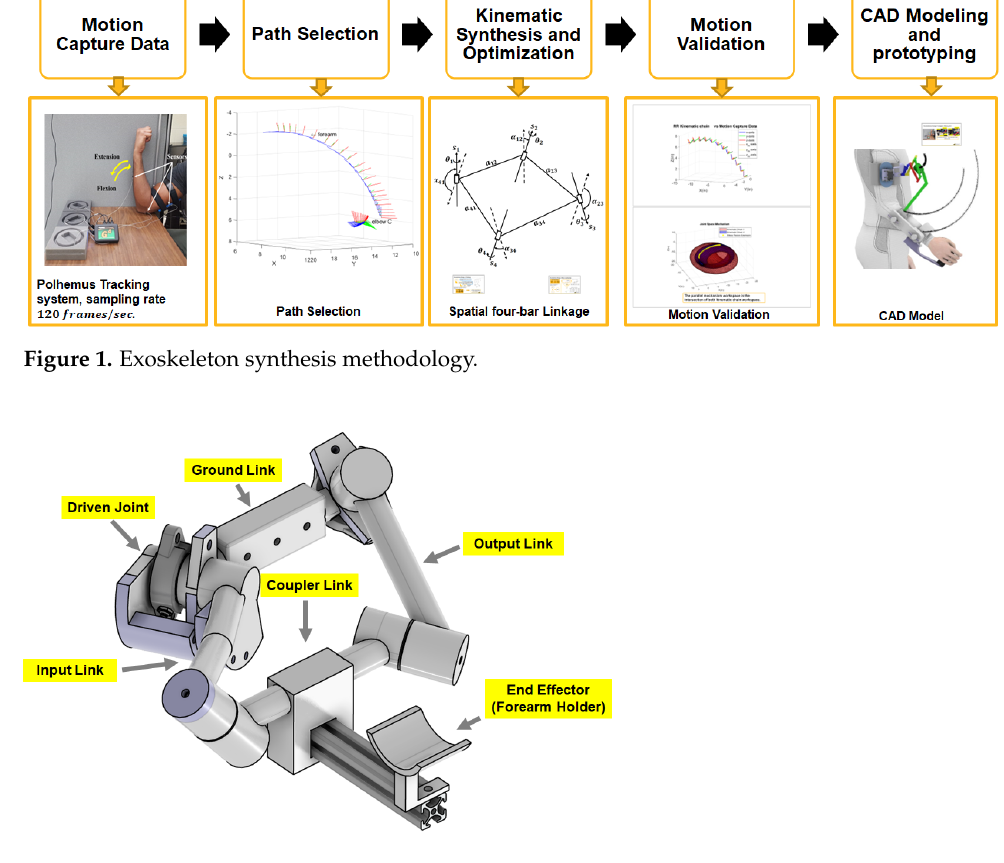
Figure 2. Exoskeleton CAD model showing the assembly and individual